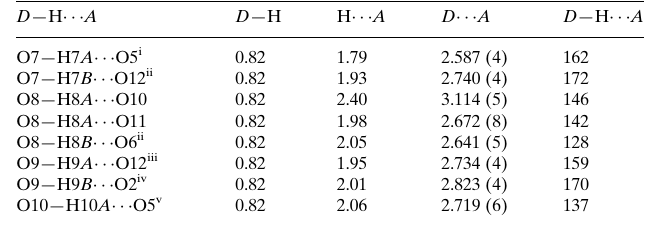
Hydrogen-bond geometry (A˚ , (cid:3)